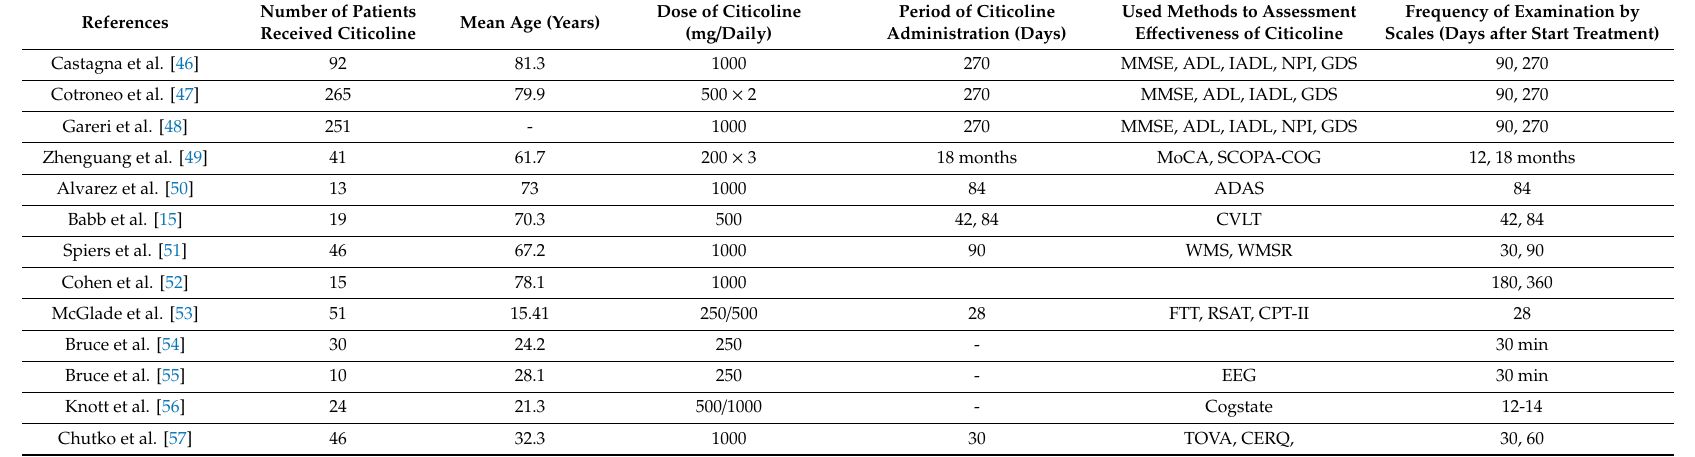
Table 3. Key clinical features of studies in dementia patients and healthy